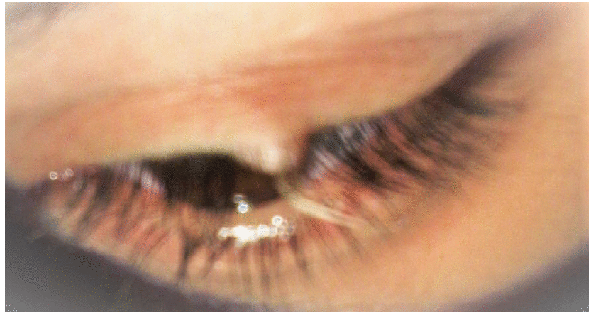
Figure 1: Clinical photograph of ectopic cilia